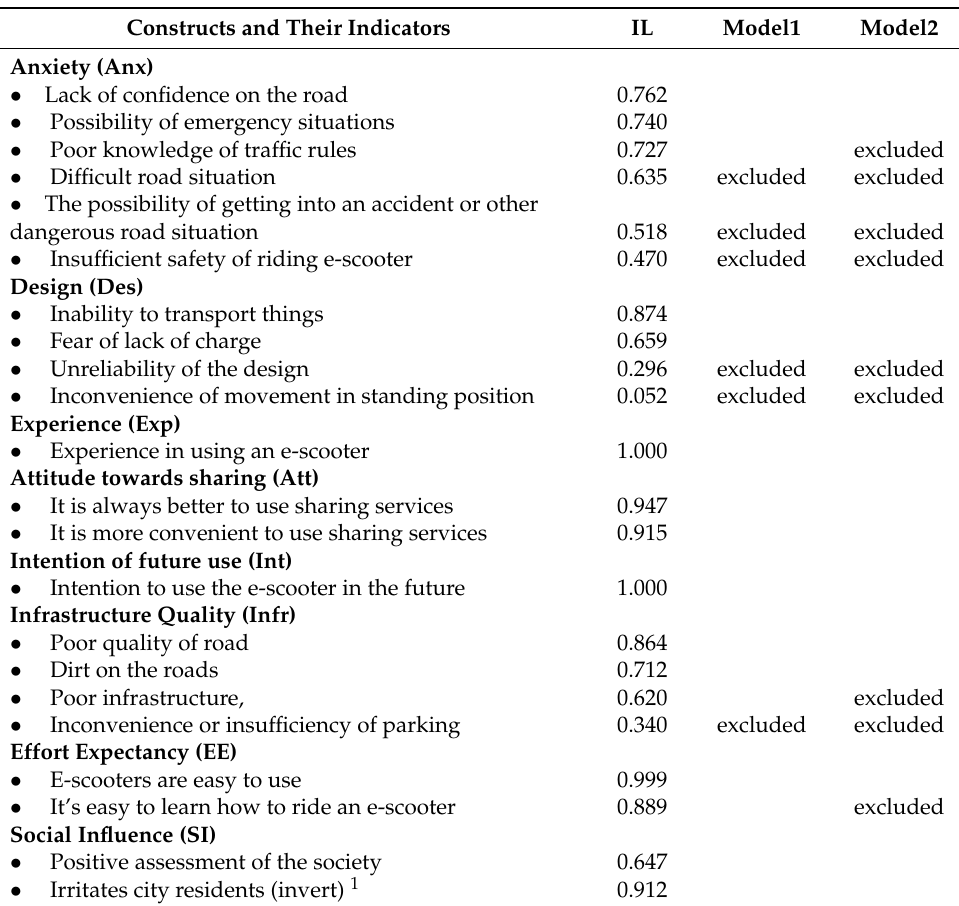
Table A2. Constructs of the model; their included and excluded indicators and their loading (IL). Constructs and Their